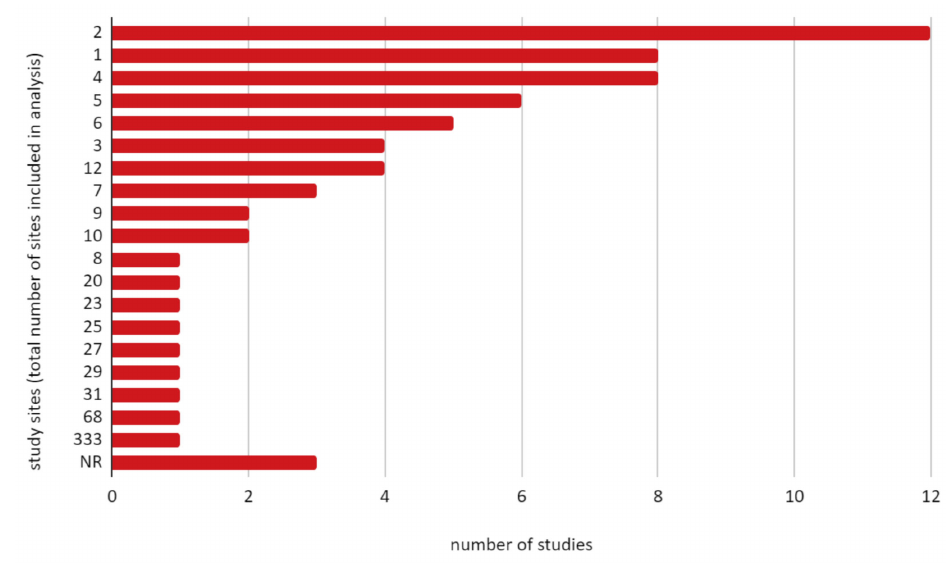
Figure 7. Number of sites included in the analysis.